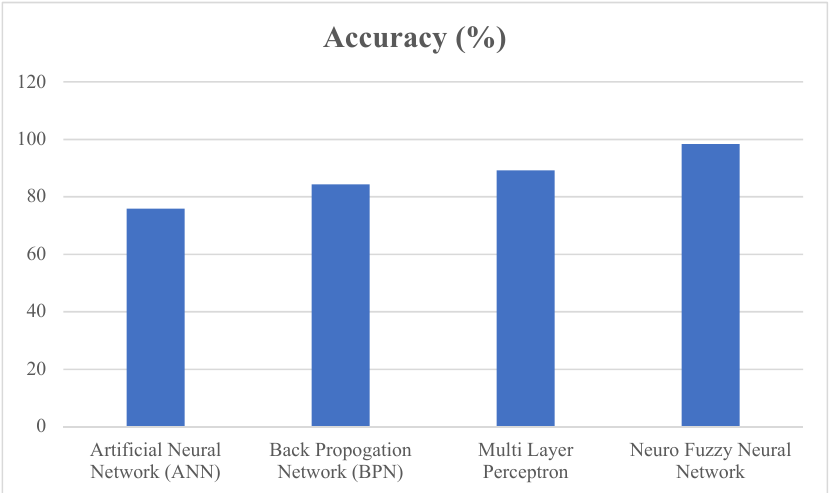
Figure 12. Accuracy comparison of different classifiers.